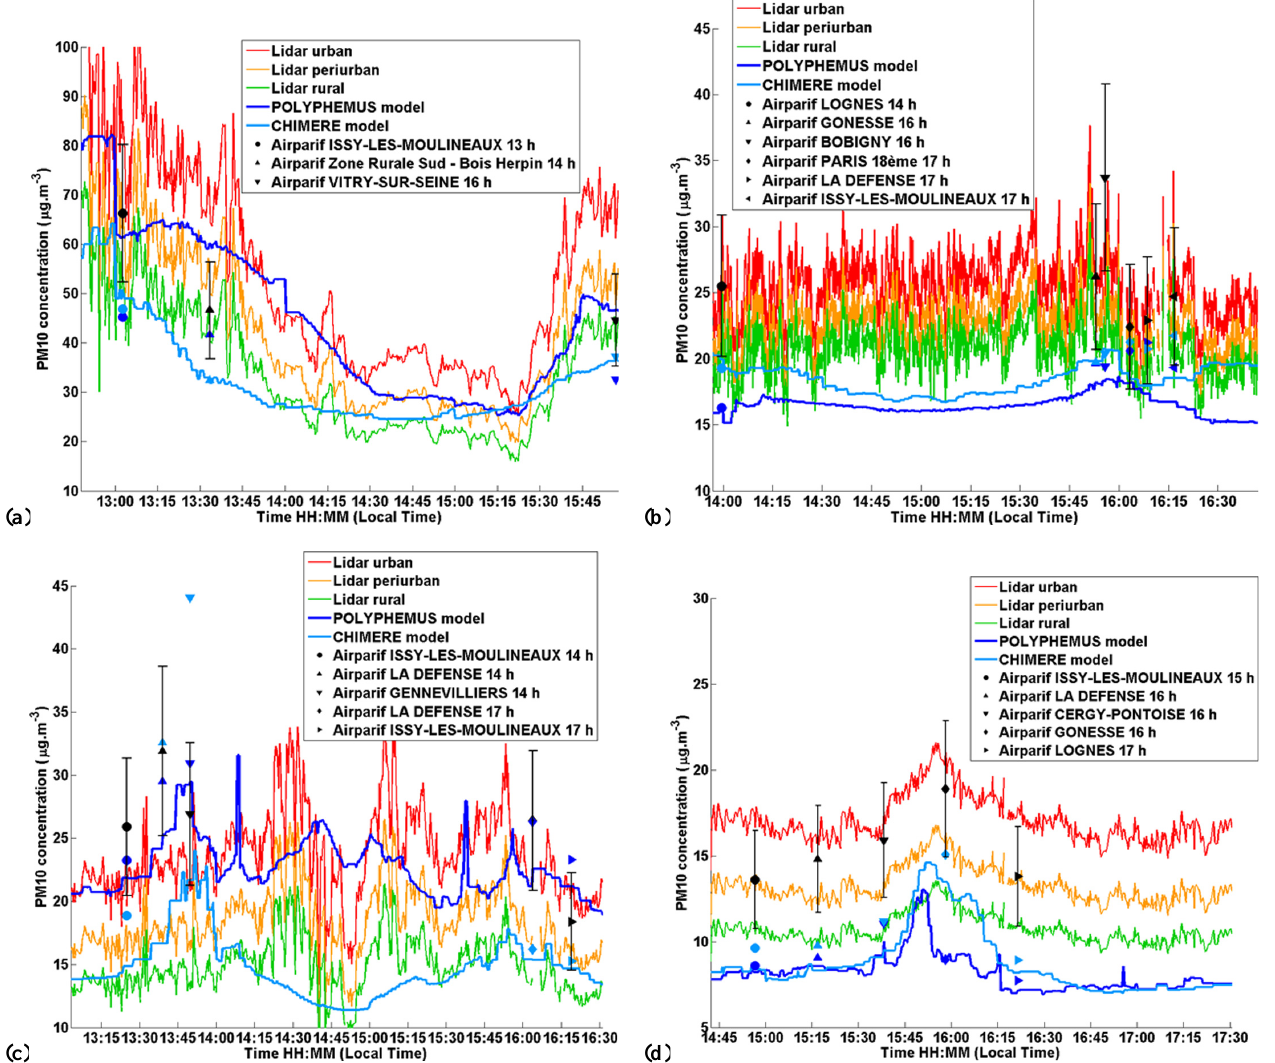
Fig. 6. Comparison for the 1 (a) , 15 (b) , 16 (c) and 26 (d) July of wet PM 10 derived from GBML using urban (red curves), peri-urban (orange) and rural relationships (green) at 210m height, and wet PM 10 extracted from POLYPHEMUS model at 210m height (in dark blue) and CHIMERE model at 250m height (in light blue). AIPARIF dry PM 10 are indicated by black symbols for the nearest stations (located at less than 10km from GBML) and dry PM 10 modeled at the lowest level are indicated with dark blue (for POLYPHEMUS) and light blue (for CHIMERE) filled symbols. Note that for the 15 July a mixing of dust and pollution relationships has been used in lidar